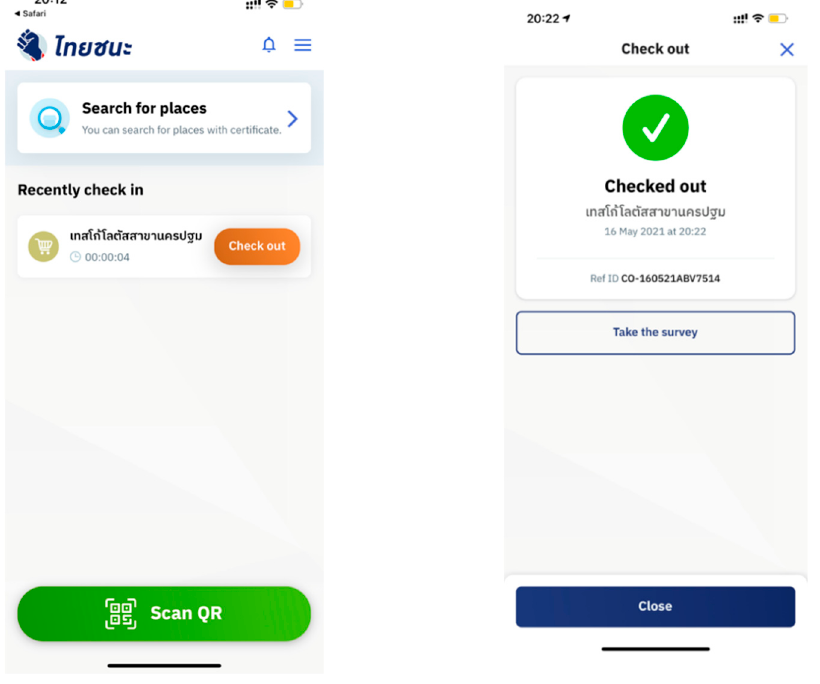
Figure 1. Thai Chana in iOS.